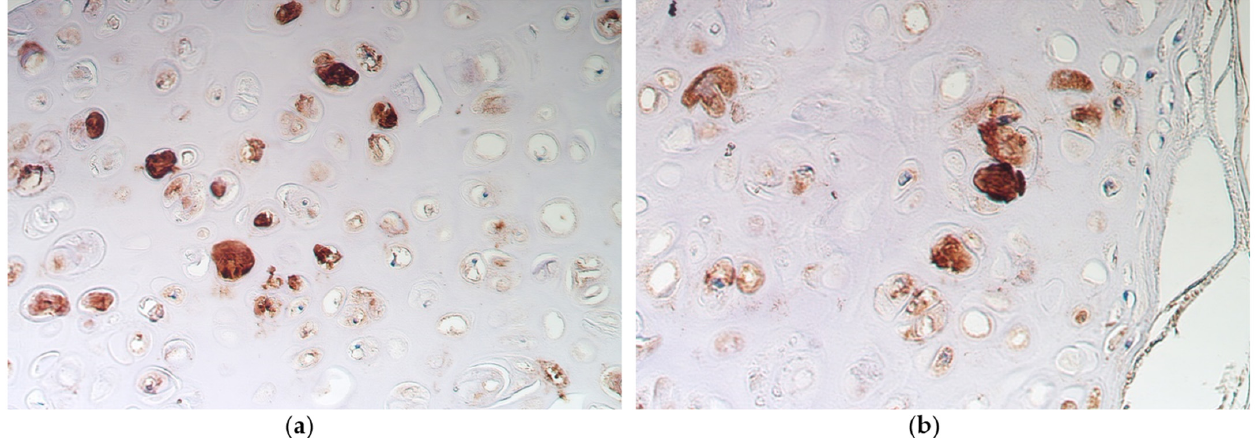
Figure 3. ( a ) Numerous nestin-positive structures in bronchial cartilage of a 54-year-old male with non-changed bronchial epithelium. Nestin IMH, X200. ( b ) Moderate number of nestin-positive structures in bronchial cartilage of an 86-year-old male with metaplastic bronchial epithelium. Nes- tin IMH, X200. Table 1. Appearance and relative number of nestin-containing and apoptotic cells in 19 relatively healthy lung tissue specimens.